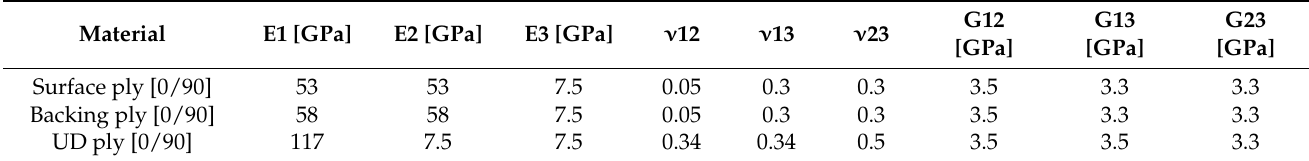
Table 2. Material properties of the used materials.